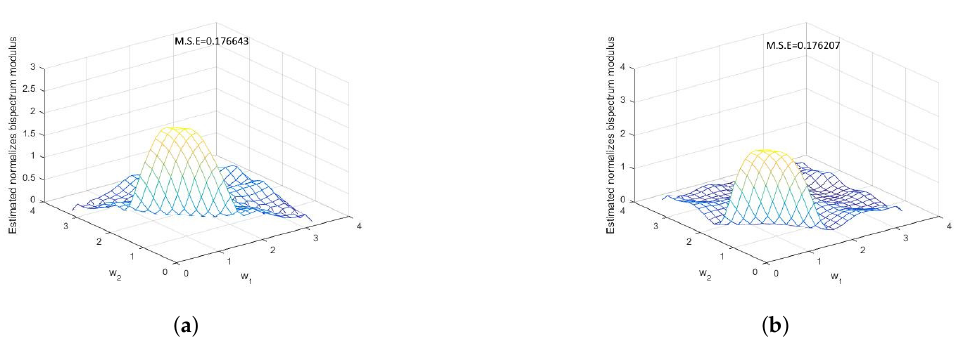
Figure 8. The estimated normalized bispectrum modulus using Daniell window. ( a ) Generated observations. ( b ) Forecasted